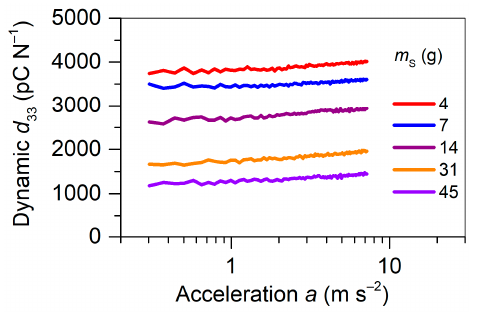
Figure 9. Dynamic 𝑑 (cid:2871)(cid:2871) coefficient as a function of acceleration measured at 30 Hz and different seismic masses, 𝑚 (cid:3020) , as indicated for the FEP/TPU/FEP–FEP/air/FEP sandwiches with the width ratio of 1 polarized at 25